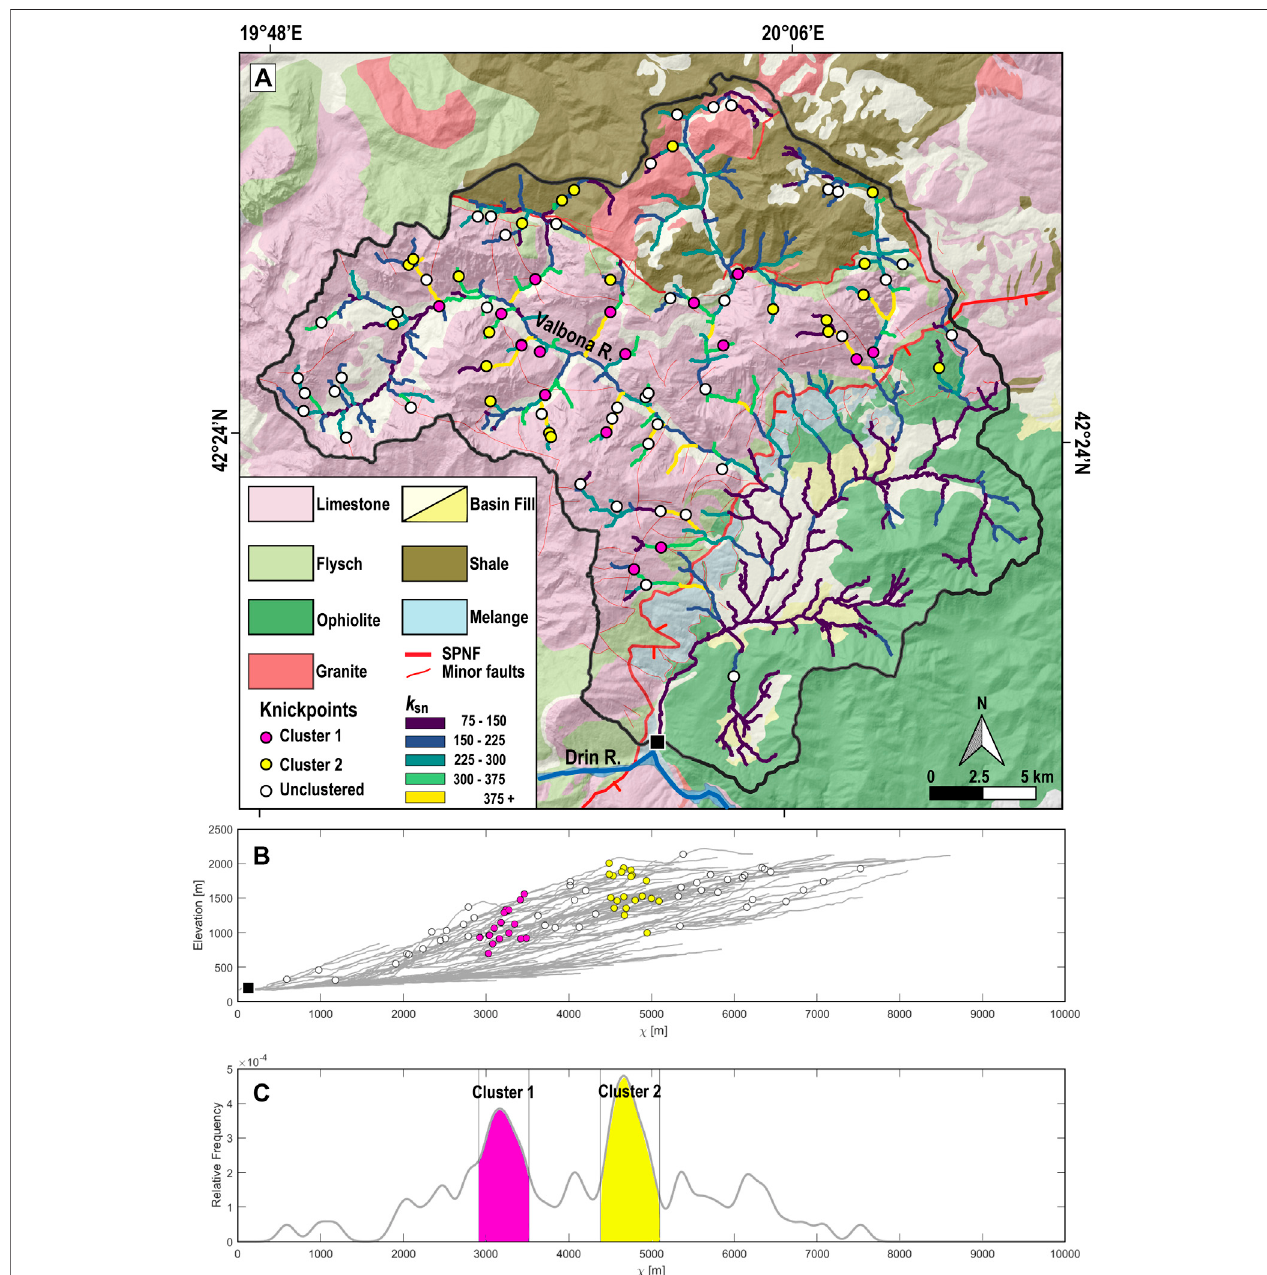
FIGURE7| MorphometricanalysisoftheriversintheTropojaBasincatchment: (A) Mapofnormalisedchannelsteepnessindex( k sn )oftheupstream-drainagearea oftheTropojaBasinfromthebaselevelindicatedasasquare in(a); (B) χ – normalisedlongitudinalpro fi lesofthestreamnetworkintheTropojaBasin.Thebaselevelisfor the plot is taken to be the con fl uence of Valbona and Drin Rivers (square in (a)). Circles indicate knickpoints colored according to the peaks in the Kernel density distribution (c); (C) Knickpoints are grouped in two clusters using the computed signi fi cant peaks in the Kernel density function (100 m width). Lithologies in (a) are from Xhomo et al. (2002). The base level for the analysis is the con fl uence of Valbona and Drin Rivers (solid square in (a)).